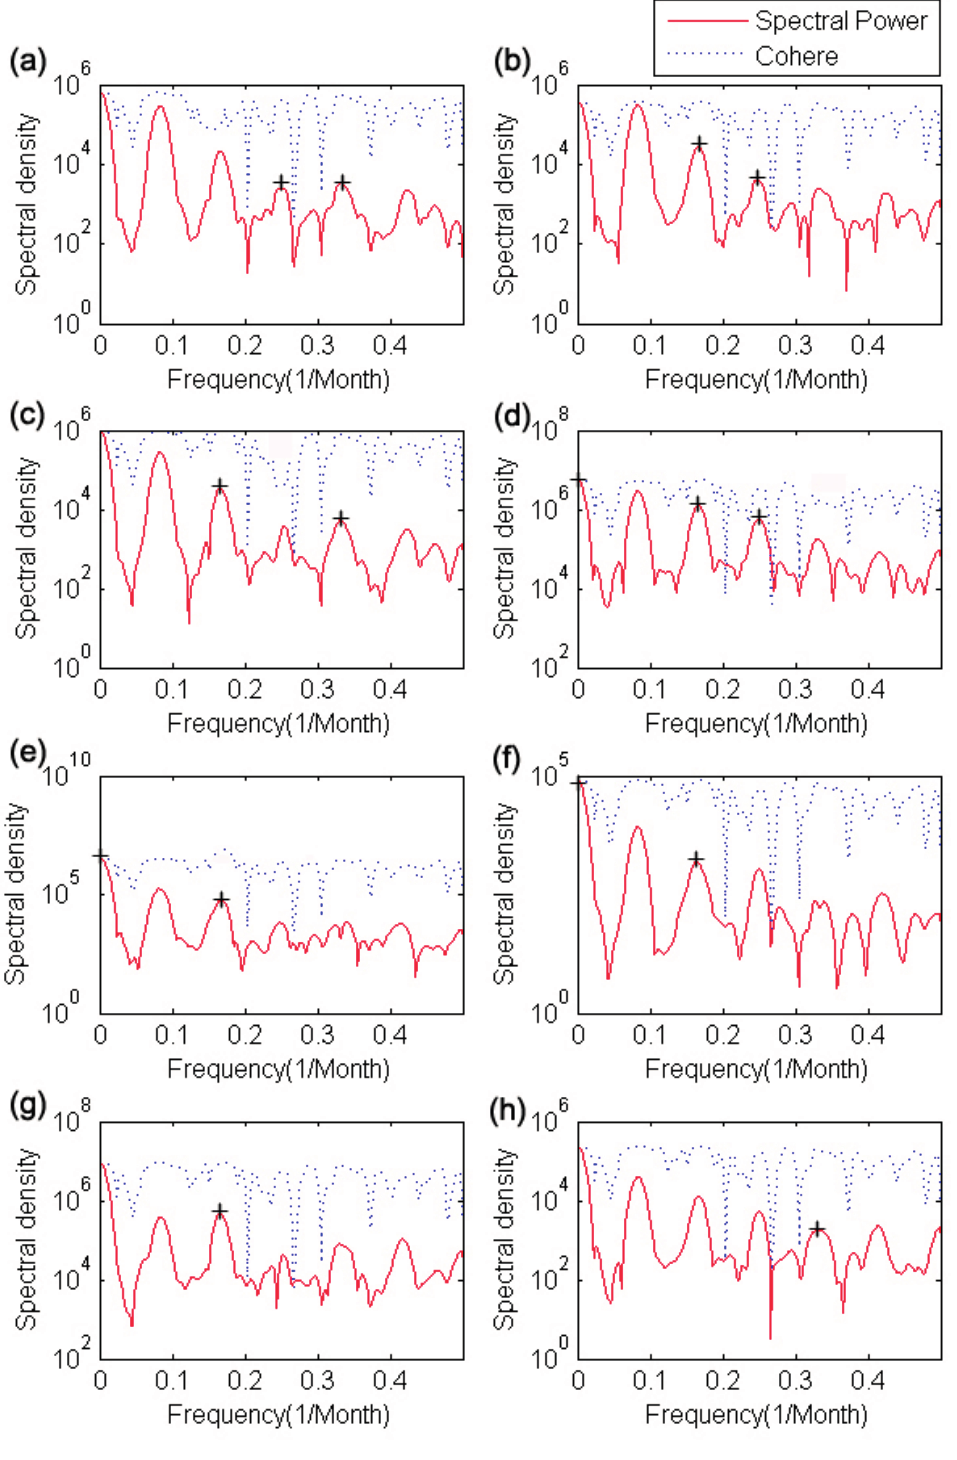
Figure 6. Cross spectrum and coherence of scrub typhus and each meteorological factor: scrub typhus with ( a ) mean temperature; ( b ) minimum temperature; ( c ) maximum temperature; ( d ) precipitation; ( e ) relative humidity; ( f ) wind speed; ( g ) duration of sunshine; and ( h ) cloud cover, all coherence results are up-scaled for visibility, and each cross spectrum (red line) and coherence (blue dot line) indicate that the correlation power and its explanation power, and + mark indicate that the frequency (1/f) has correlation power between scrub typhus and each meteorological